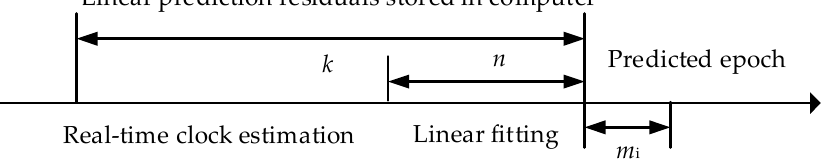
Figure 4. Workflow-diagram for one single epoch m i .